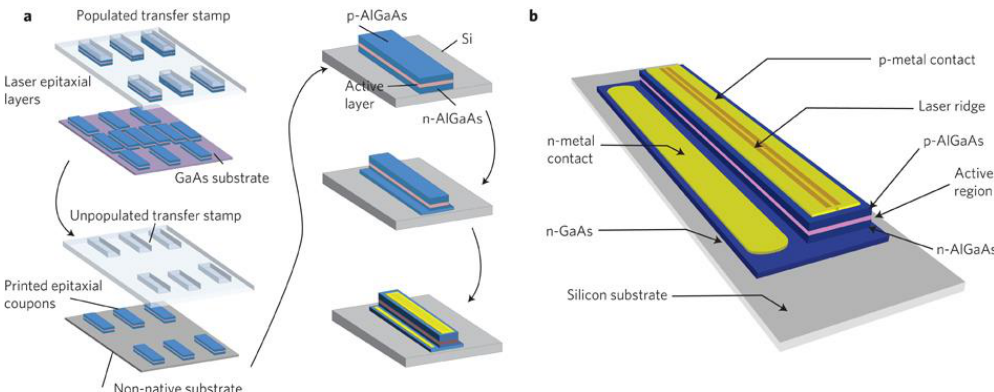
Figure 6. ( a ) Schematic of the transfer of unprocessed coupons of epitaxial material from a native III-V wafer (containing the desired layer structure) to the host substrate. The laser devices are fabricated in parallel on the host substrate using lithographically-defined etched facets to align to the underlying alignment marks. ( b ) Schematic of a laser on the silicon substrate (reprinted from [38]).